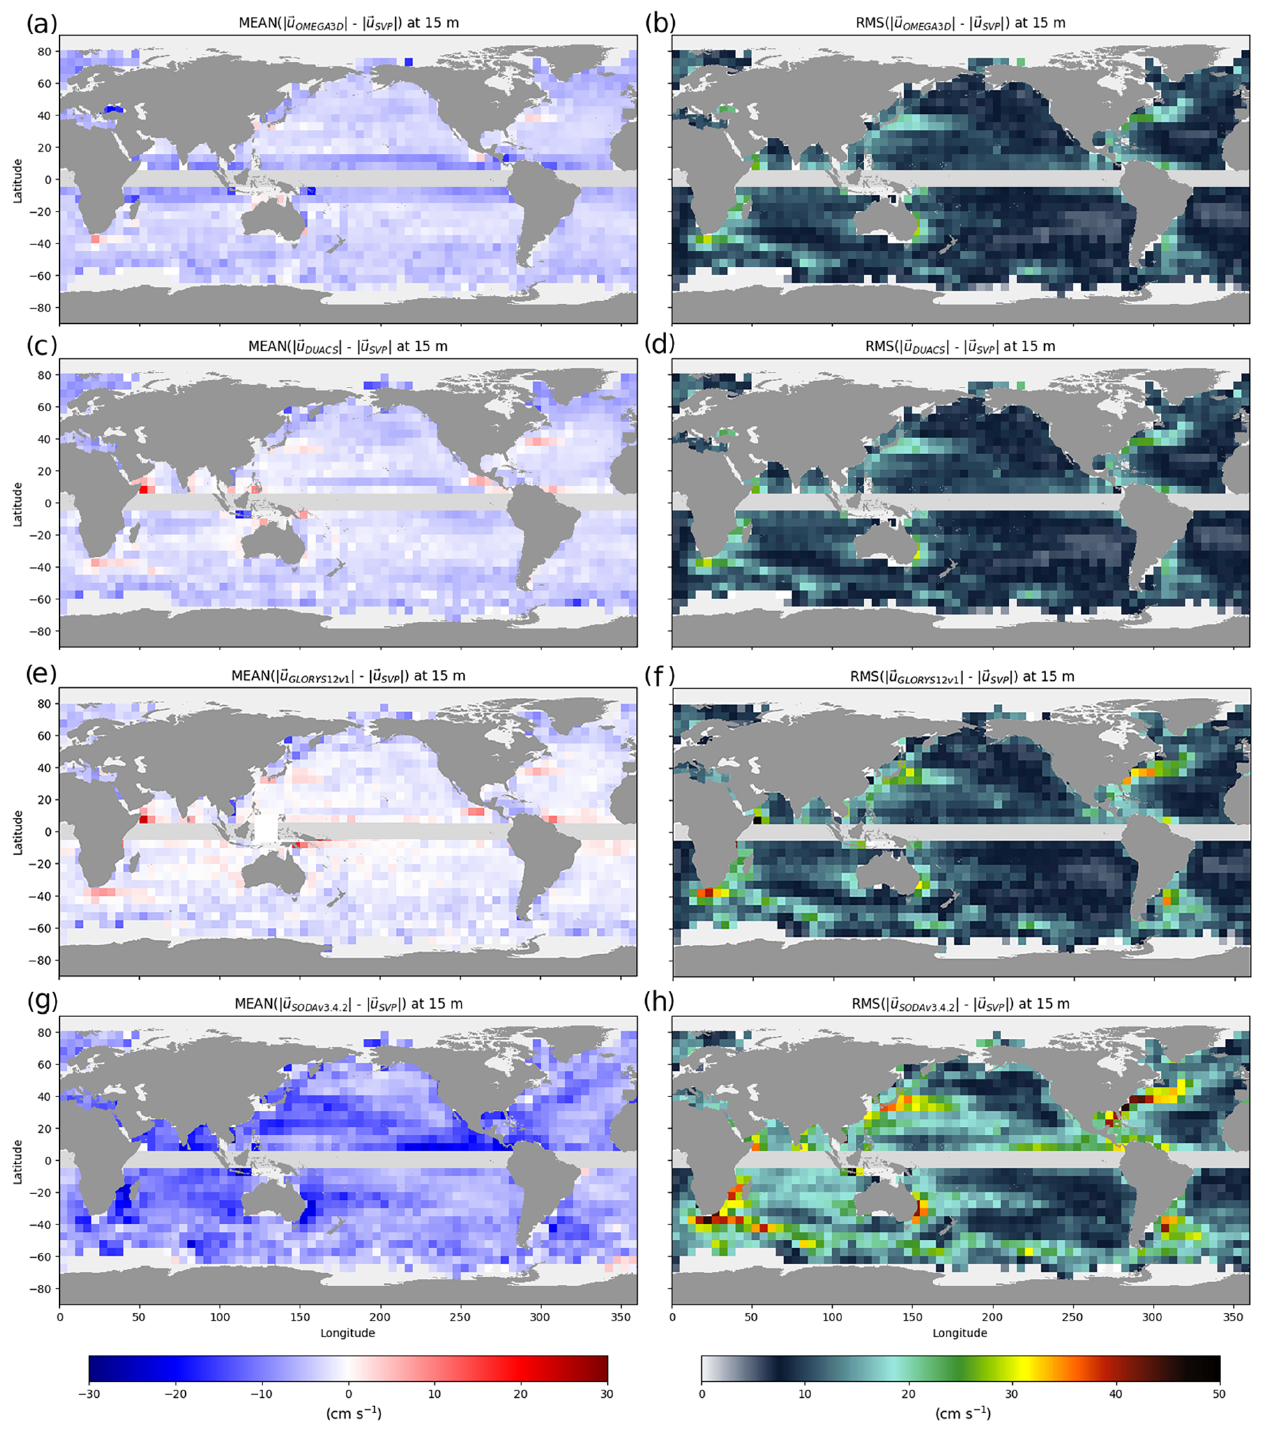
Figure 4. Mean and root mean square differences between OMEGA3D (a, b) , DUACS (c, d) , GLORYS12v1 (e, f) and SODAv3.4.2 (g, h) velocities at 15m depth and co-located SVP